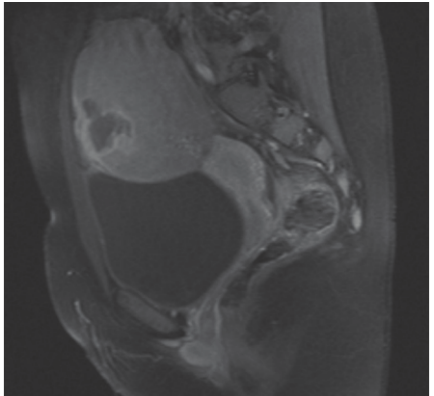
Figure 1: Sagittal T2-contrast-enhanced, fat saturated MR image of the mass.